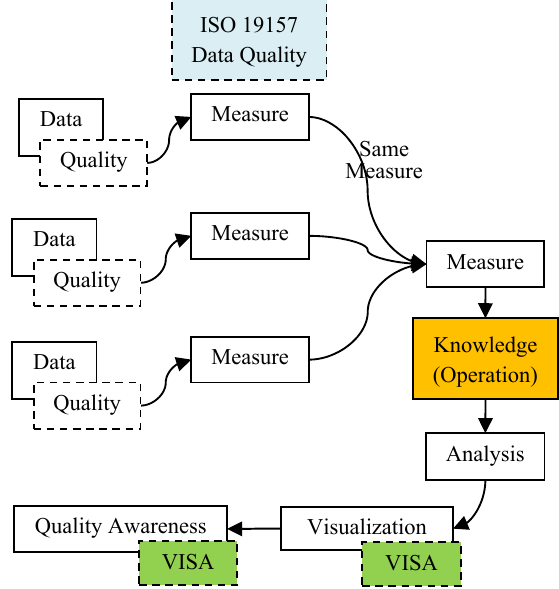
Figure 4. Detailed flowchart of VISA-enabled interface